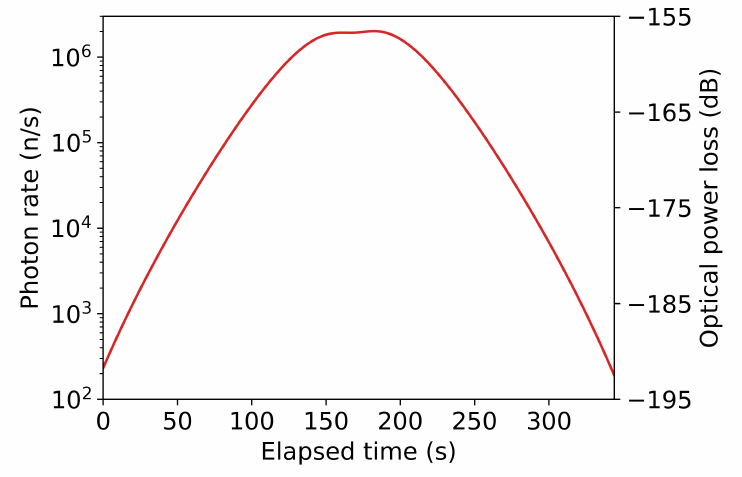
Figure 4. Excess photon rate at the QKD ground station and optical power loss over time (represented in seconds elapsed since the satellite came into view of the ground station) achieved for a 1 kW laser launched via a 10 cm telescope 100 km from the QKD